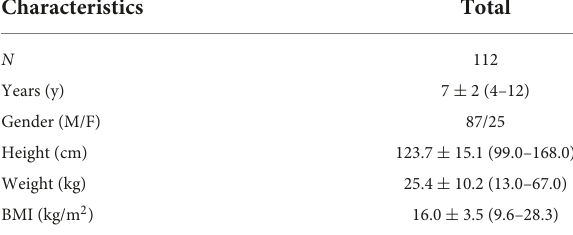
TABLE 1 Characteristics of 112